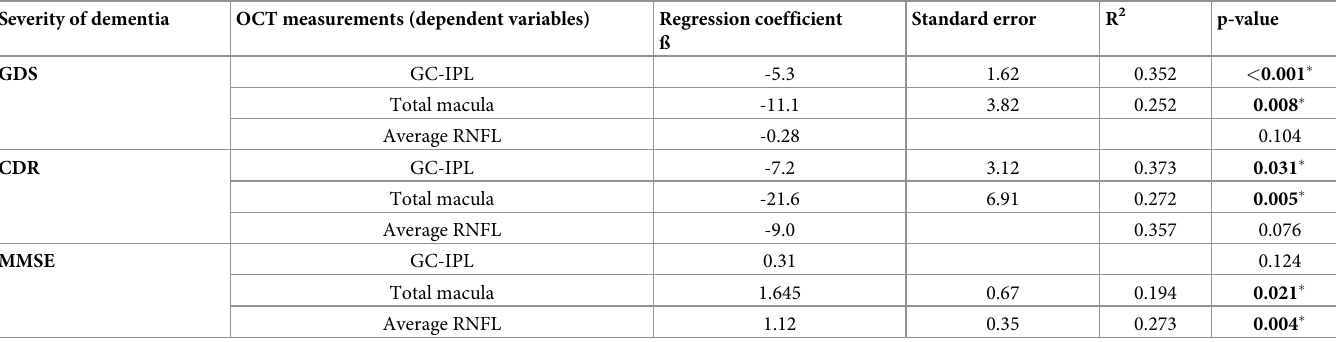
OCT: optical coherence tomography, MMSE: mini-mental status examination, CDR: clinical dementia rating, GDS: global deterioration scale, � bold type indicates statistical